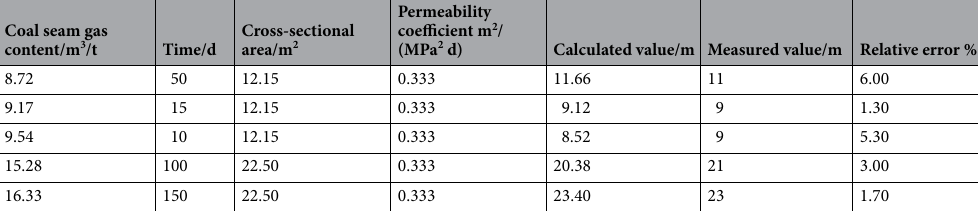
Table 7. Calculated error in gas emission zone size at different